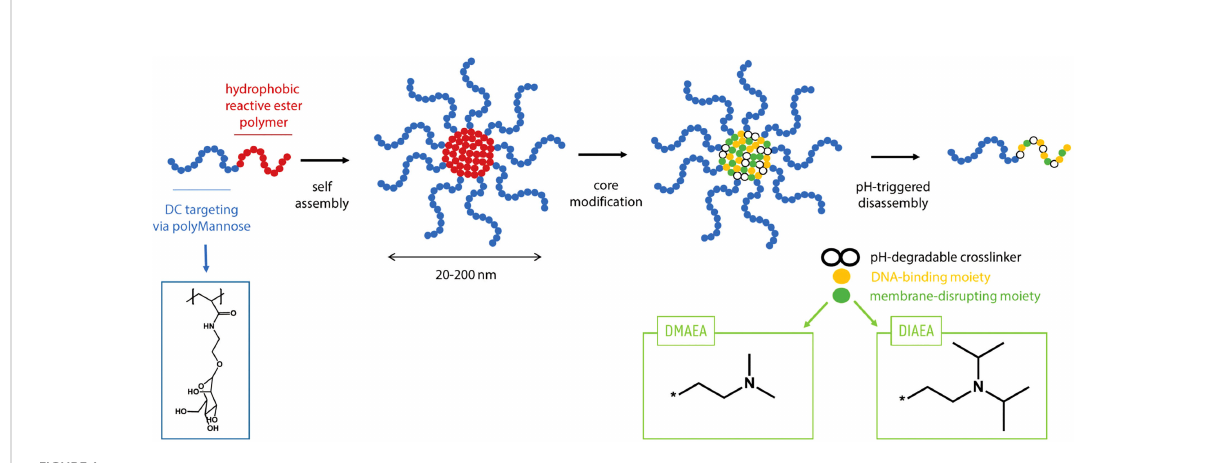
FIGURE 1 Principle of using nanogel for adjuvant formulation: Polymers consisting of a polyMannose chain which targets Dendritic cells and a hydrophobic reactive ester polymer which forms the positively charged core. The polymers can self-assemble in a solvent and disassemble upon endocytosis due to lower